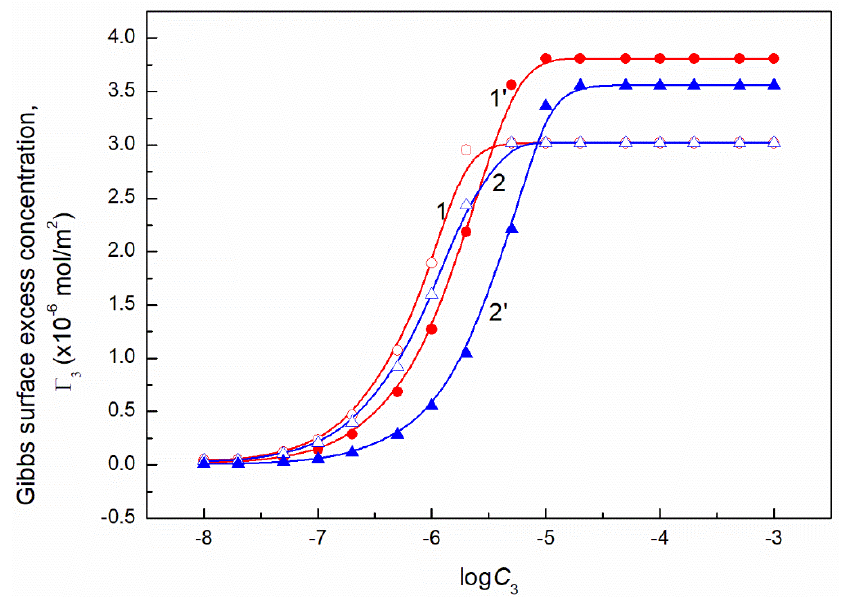
Figure 14. A plot of the Gibbs surface excess concentration of FC1 ( Γ 3 ) calculated from Equation (9) based on the measured surface tension of the ternary mixture at the constant concentration of the CTAB + TX100 at γ LV equal 60 mN/m (curve 1) and 50 mN/m (curve 2) and on the contribution of FC2 to the reduction of water surface tension (curve 1’corresponds to γ LV = 60 mN/m and curve 2’ corresponds to γ LV = 50 mN/m) vs. the logarithm of the FC2 concentration ( logC 3